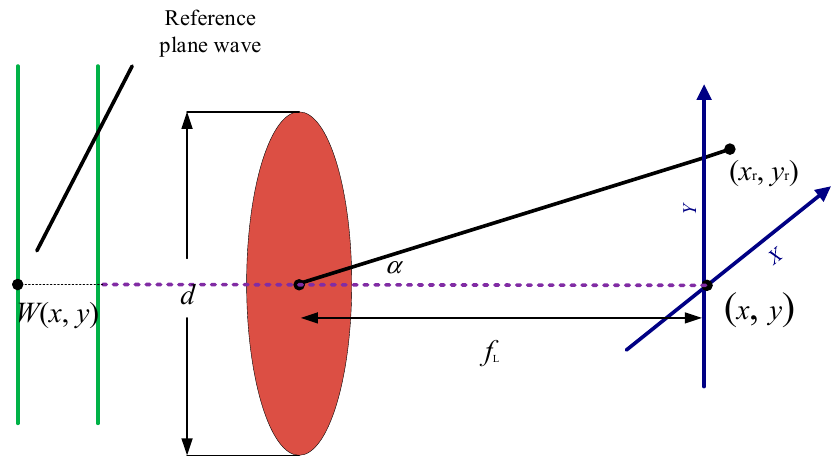
Figure 3. Schematic sketch of the wavefront deviation.